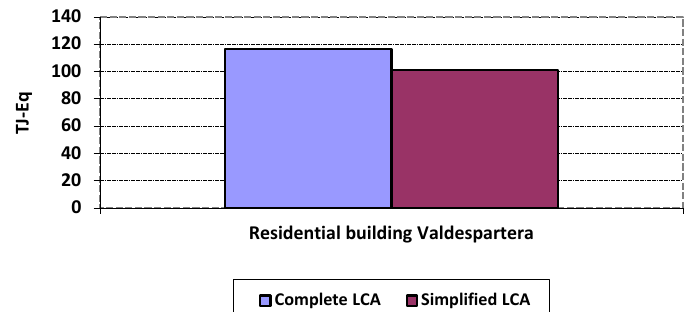
Figure 3. Comparison of the embodied energy impact (in equivalent terajoules: TJ-Eq) in the building analyzed using the complete LCA and the simplified LCA.